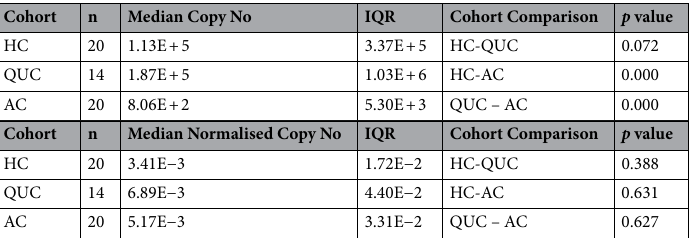
Table 3. Median copy number/mg and median relative abundance of R. hominis after normalisation for total bacterial copy number in each patient cohort. p values for inter-cohort